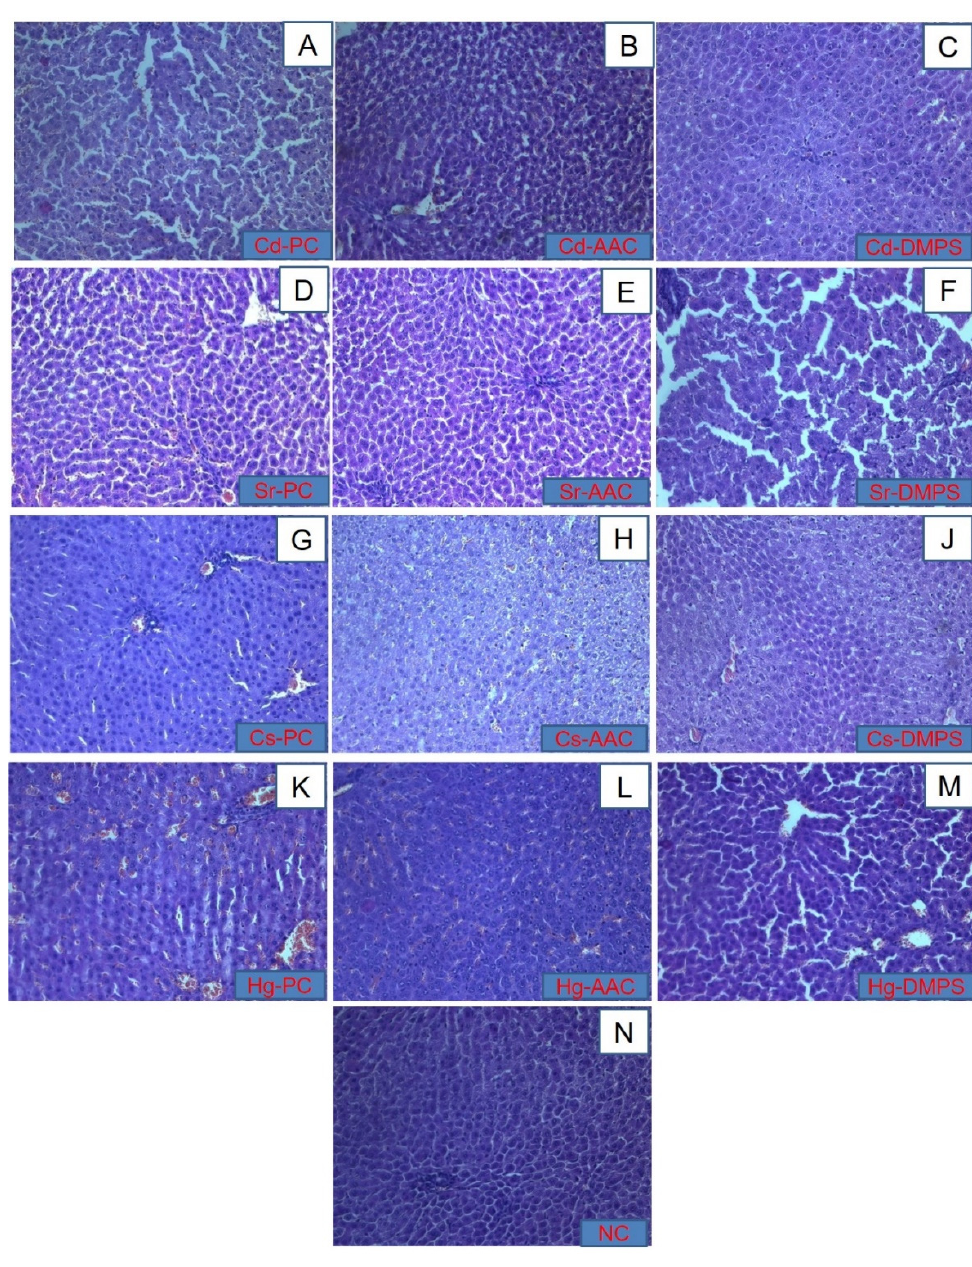
Figure 3. Histological images of liver from ( A ) Cd-PC, ( B ) Cd-AAC, ( C ) Cd-DMPS, ( D ) Sr-AAC ( E ) Sr-AAC ( F ) Sr- DMPS, ( G ) Cs-PC ( H ) Cs-AAC ( J ) Cs-DMPS ( K ) Hg-PC ( L ) Hg-AAC ( M ) Hg-DMPS subgroups, and ( N ) NC group, 100 × magnification, H&E